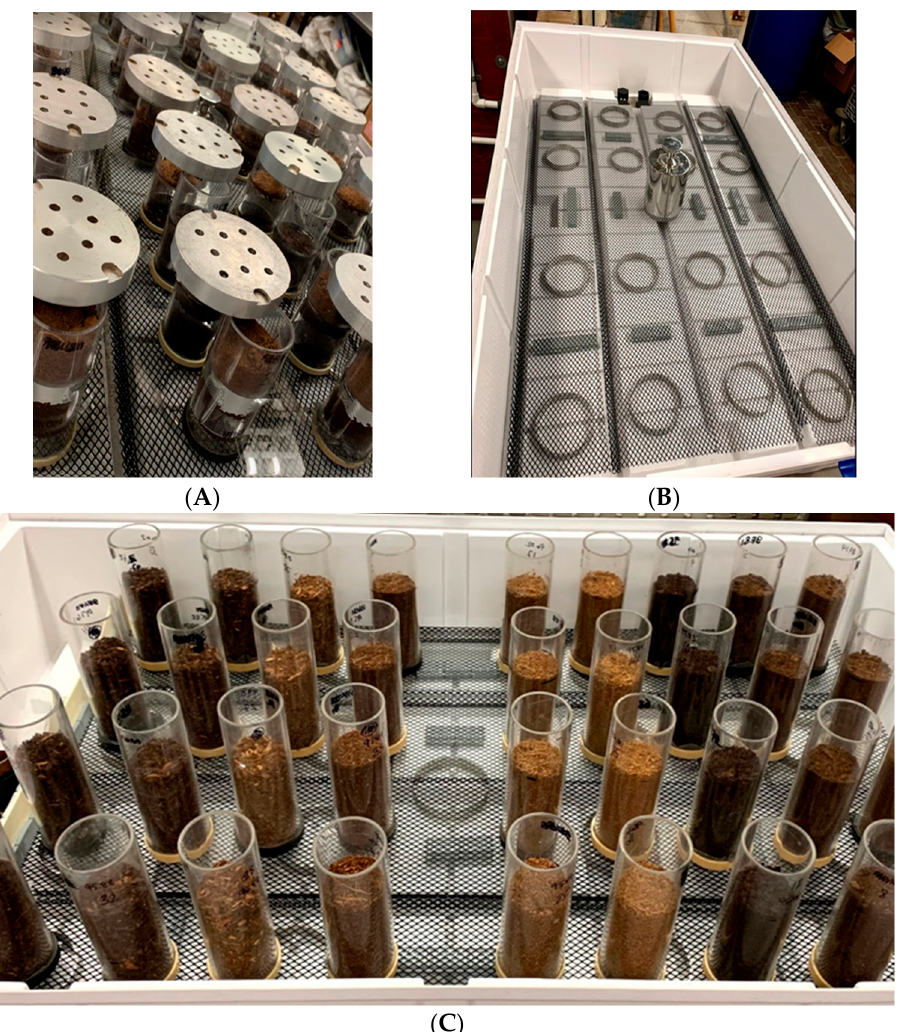
Figure 1. Ebb and flood subirrigation system. ( A ) Container capacity testing with 2 kg aluminum weights. ( B ) Partially constructed ebb and flood unit with aluminum rings with mesh screen. ( C ) Fully constructed system completes with packed substrate